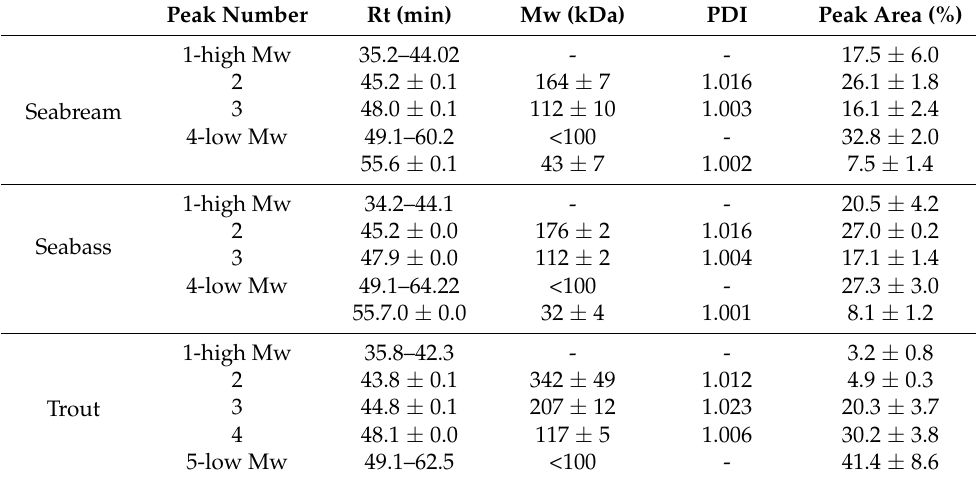
Table 3. Molecular weight (kDa) of gelatin distributions from trout, seabass, and seabream shown in Figure 1. Rt: retention time; Mw: weight average molecular weight; PDI: polydispersity index. Peak area (%) corresponds to refractive index detector. Values are represented as mean ± standard deviation ( n =